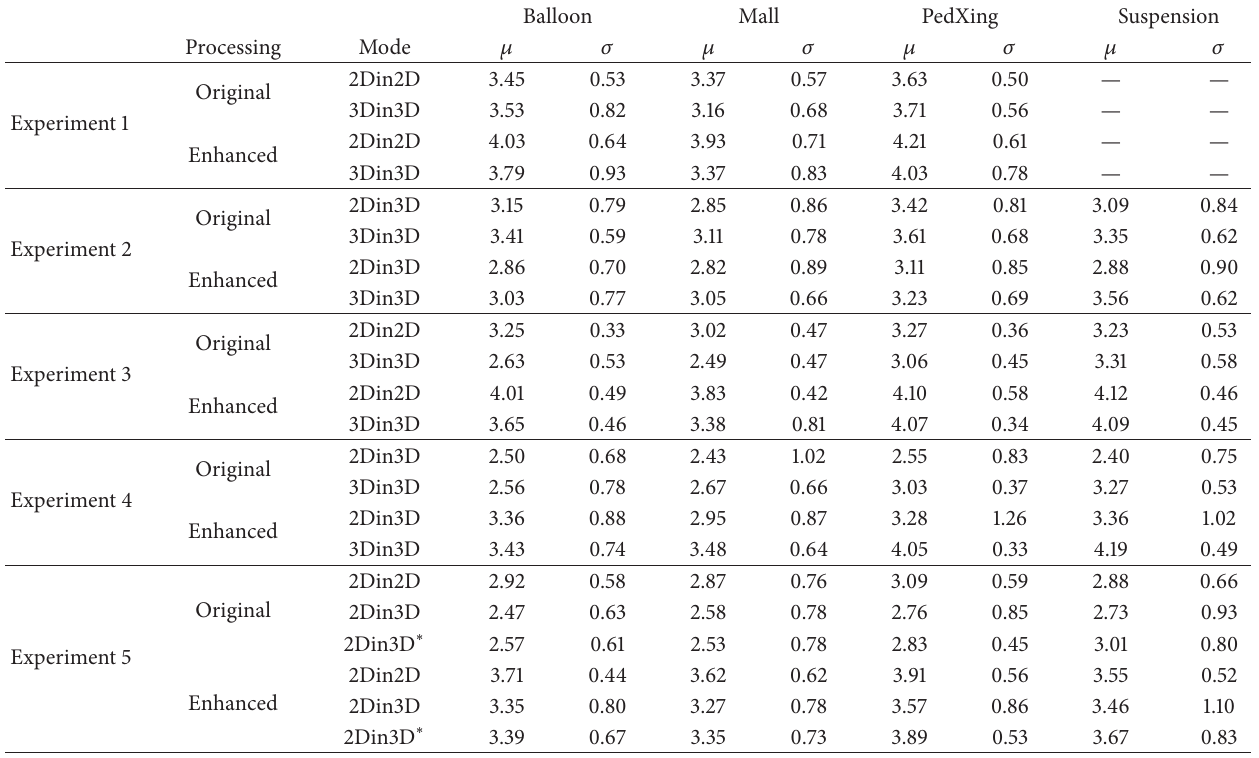
Table 4: Overview of all the mean scores and standard deviations for all clips and all experiments listed in Table 3.